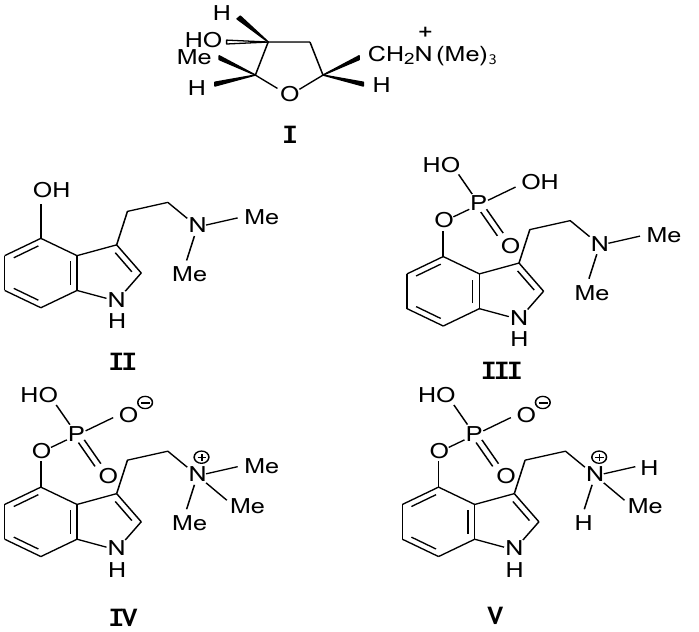
Figure 3. Structures of compounds isolated from the mushrooms of the genus Inocybe : I. muscarine; II. psilocin; III. psilocybin; IV. aeruginascin and V. baeocystin.